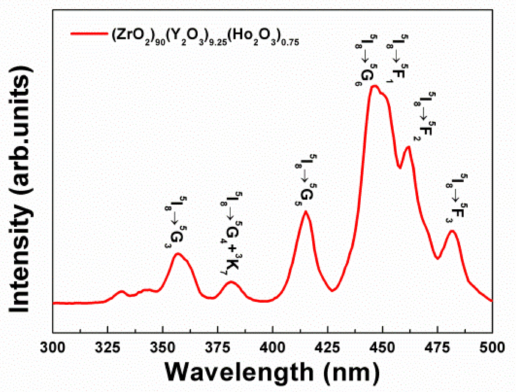
Figure 5. PLE spectrum monitored at 551 nm for (ZrO 2 ) 90 (Y 2 O 3 ) 9.25 (Ho 2 O 3 ) 0.75